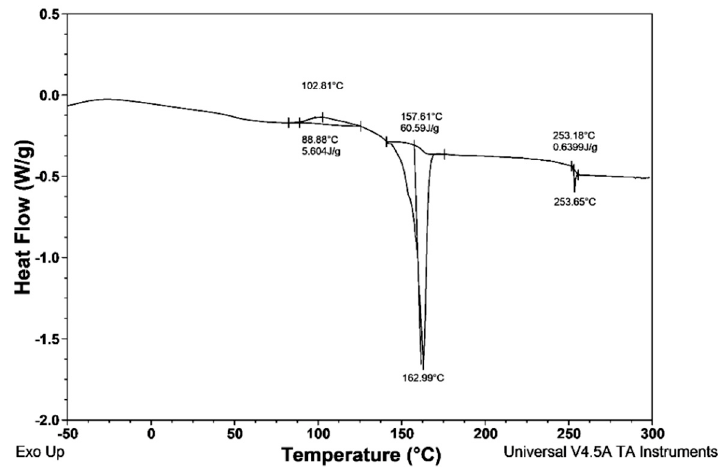
Figure 8. Thermograph of nonwoven with functional additives WSB 1 .